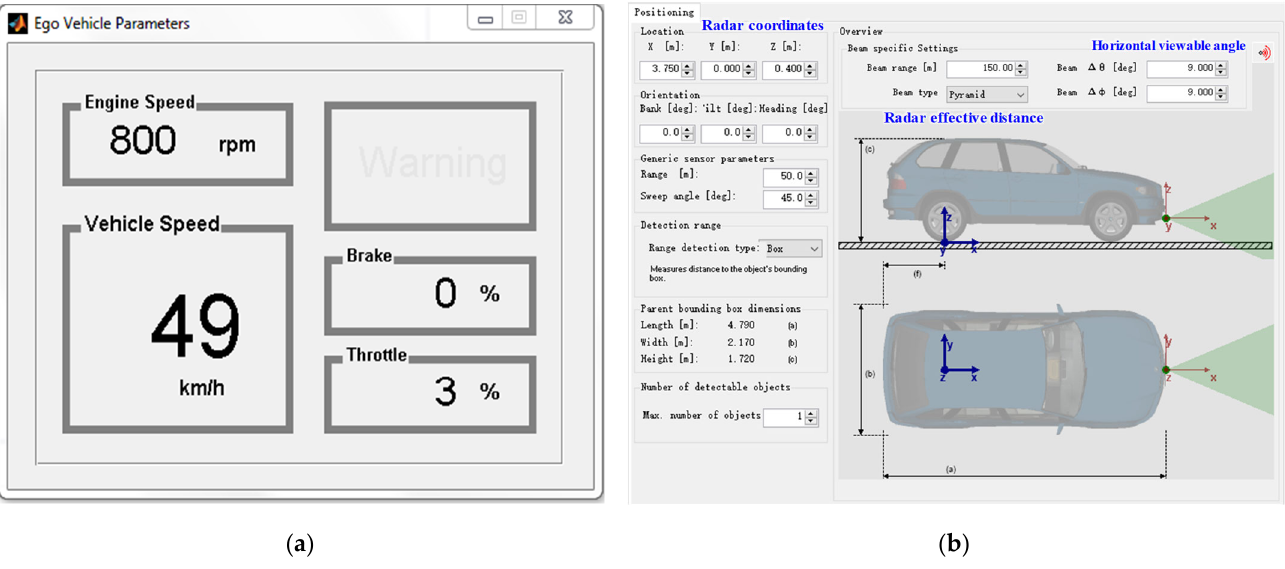
Figure 10. Simulation results of the dynamic visualization subroutine: ( a ) autonomous vehicle brak ‐ ing parameters; ( b ) vehicle equipped with radar monitoring. braking parameters; ( b ) vehicle equipped with radar